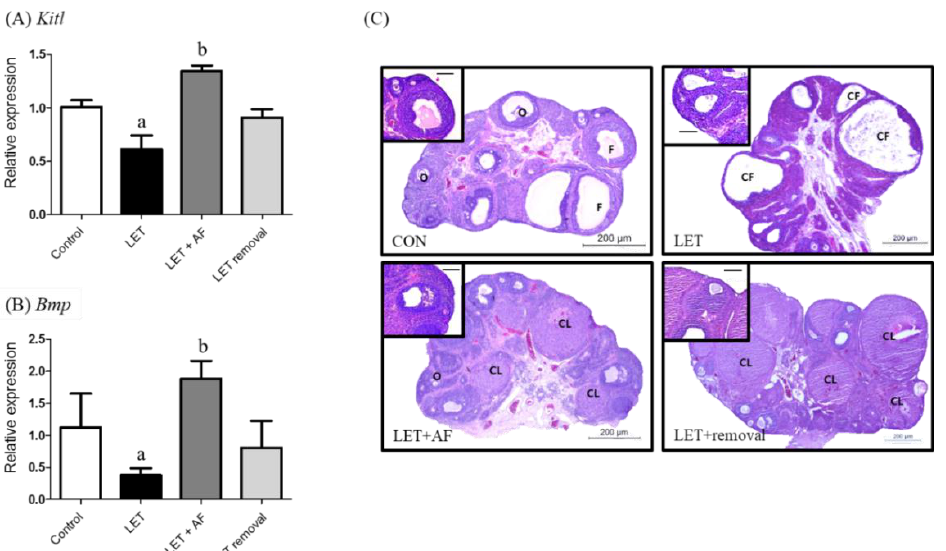
Figure 4. Effects of 2-week treatment with A. fistulosum root extract on follicular genesis and growth